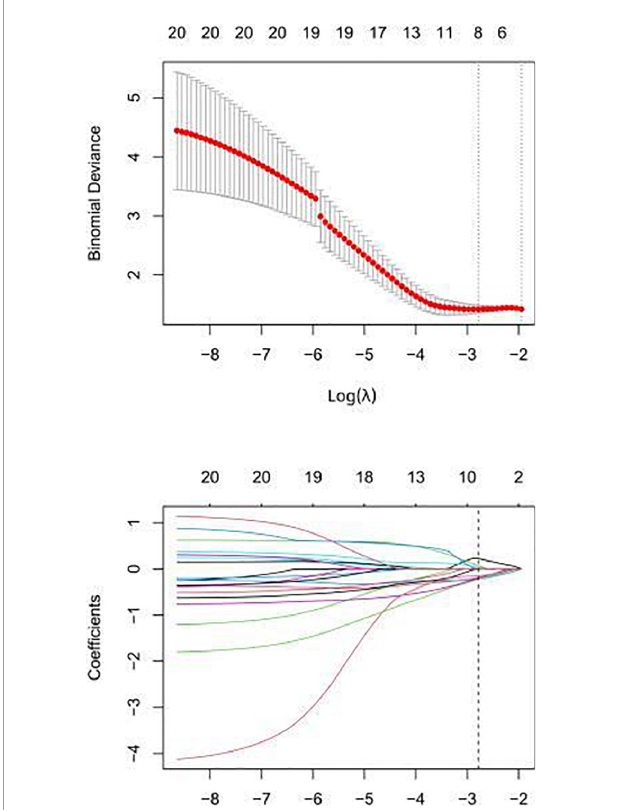
FIGURE3 In the lasso regression model, the folding cross test is used to select the optimal value of the hyperparameter λ , and the lowest is the feature that best matches the true